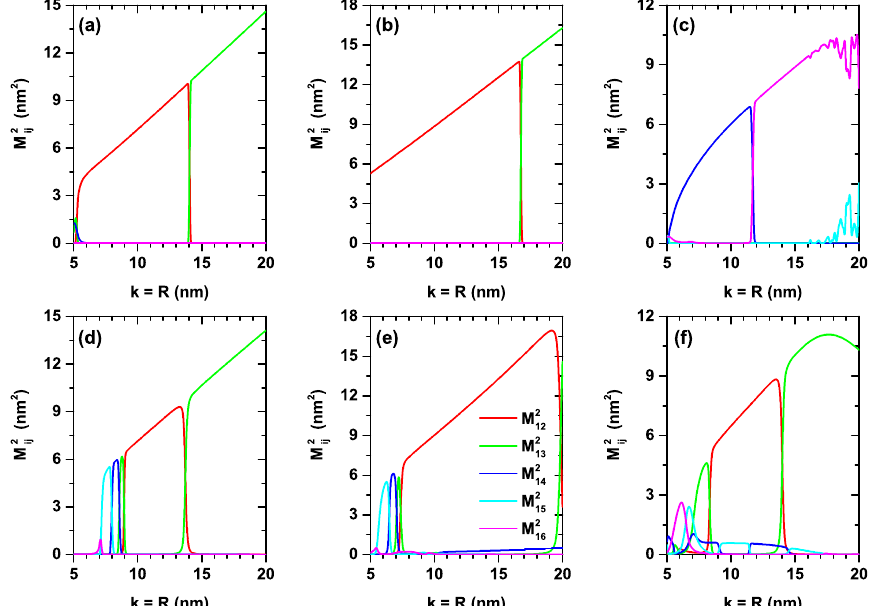
Figure 6. Reduced square of the dipole matrix element between the lowest confined electron states ( M 2 / e 2 , n = 2,3,4, 5,6) within the CQD as a function of the simultaneous variation of the k -width 1 n in the axial direction and the R -radius in the radial direction. Calculations are for zero ( a – c ) and F = 50kV/cm ( d – f ) with l = 0. The results are reported for the three considered finite axial confinement potentials: V 2 ( z ) ( a , d ), V 3 ( z ) ( b , e ) and V 4 ( z ) ( c , f